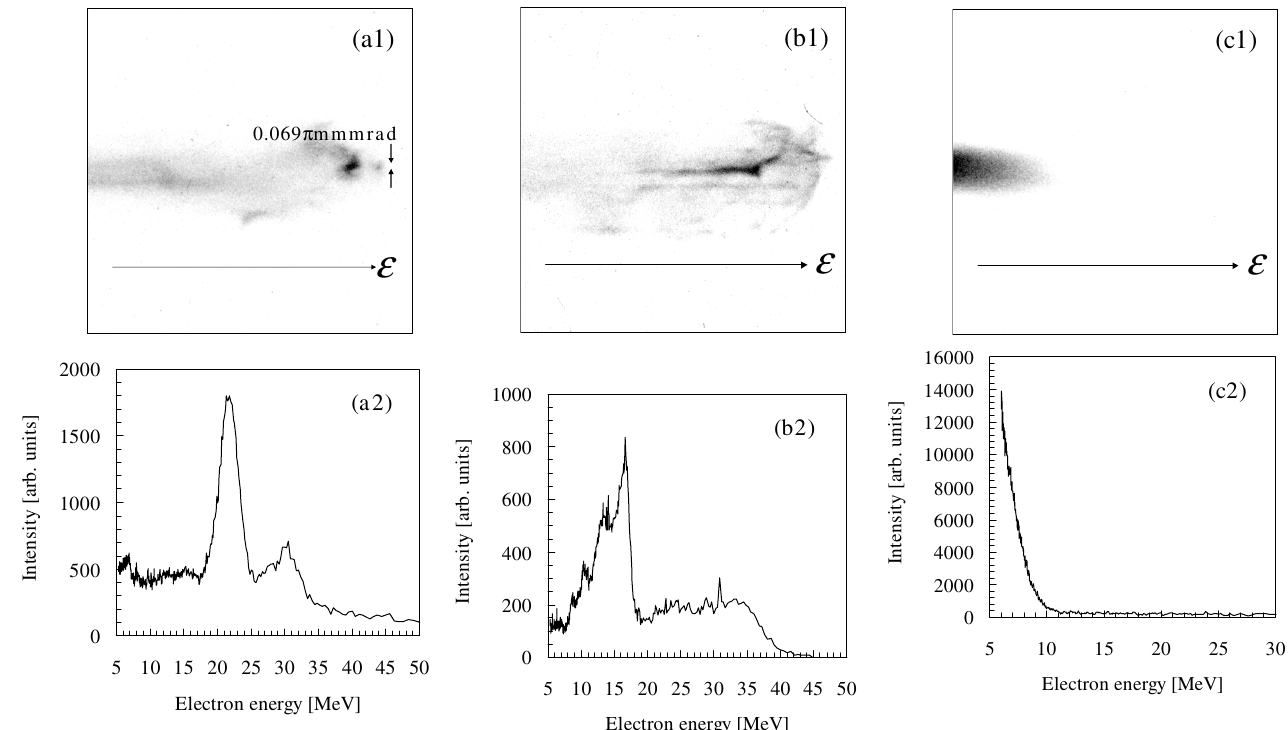
FIG. 3. Spatial distributions of the electron deflected by a magnetic electron deflector and the energy spectrum: (a) and (b) with quasimonoenergetic distribution; (c) with Maxwell-like energy distribution, respectively.